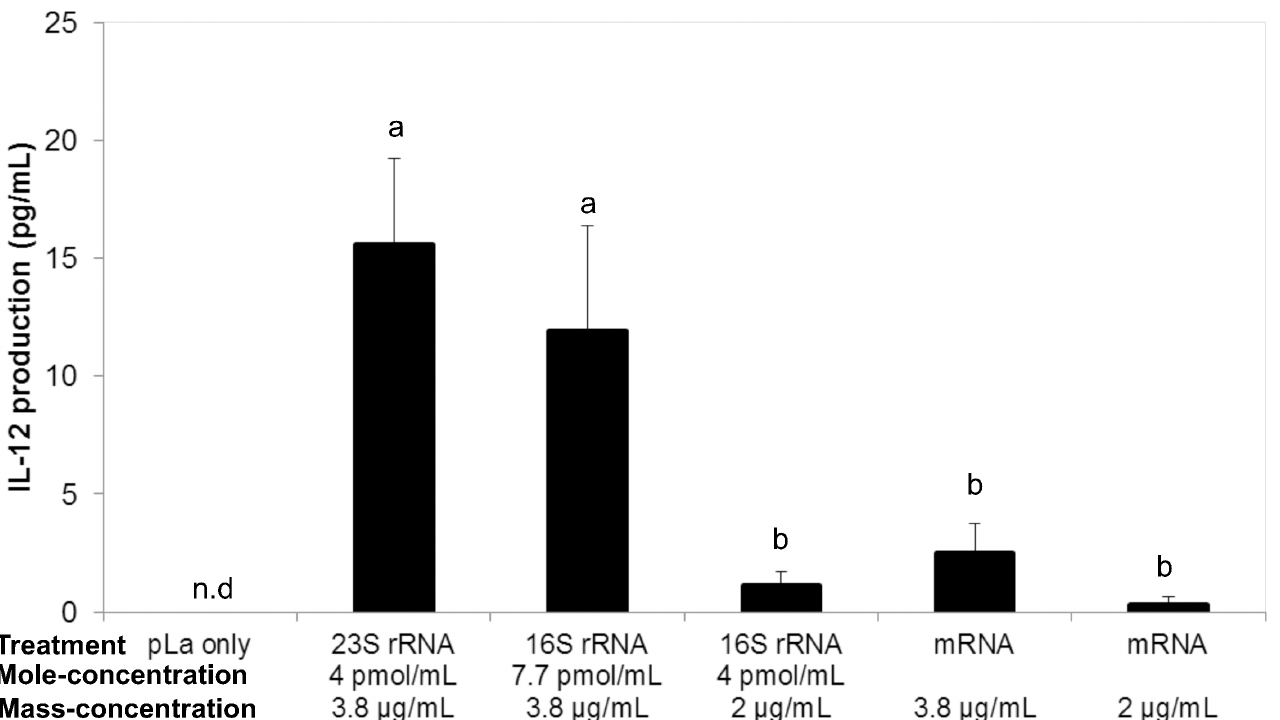
Fig 4. Effect of stimulation by rRNA and mRNA from E . faecalis EC-12 on IL-12 production. Fragmented 23S rRNA and 16S rRNA, and mRNA from E . faecalis EC-12 was transfected using pLa to PMA-differentiated THP-1 cells. After 24 h of incubation, the concentration of IL-12 protein in the culture supernatant was measured using enzyme-linked immunosorbent assay. Bars sharing the same letter are not significantly different at P < 0.01, mean ± SD, n = 4.